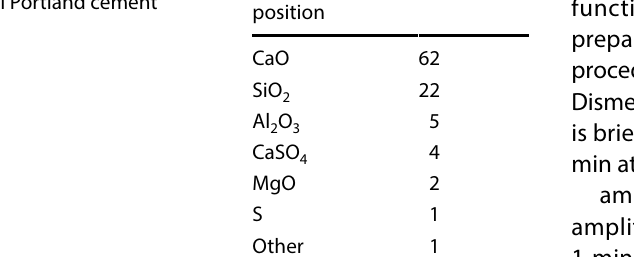
Table 1 Chemical composition of type I Portland cement